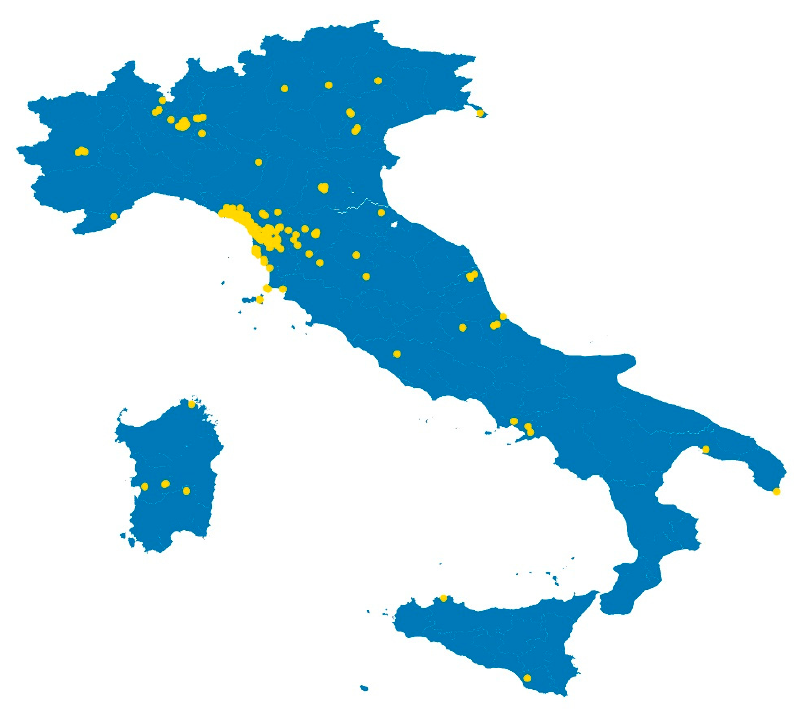
Figure 4. Dress-COV: users’ distribution in Italy.